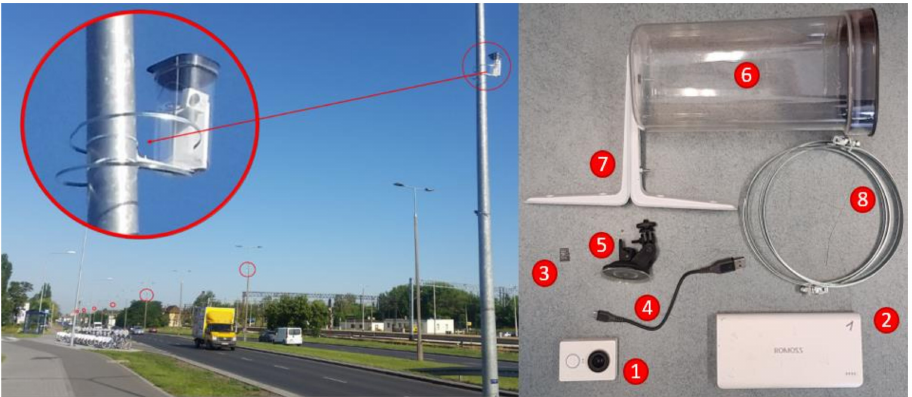
Figure 3. Arrangement of measurement kits along Kamienna Street in Bydgoszcz, Poland (where: 1—camera, 2—power bank, 3—memory card, 4—power supply cable, 5—camera holder, 6—weatherproof enclosure, 7—support sections,